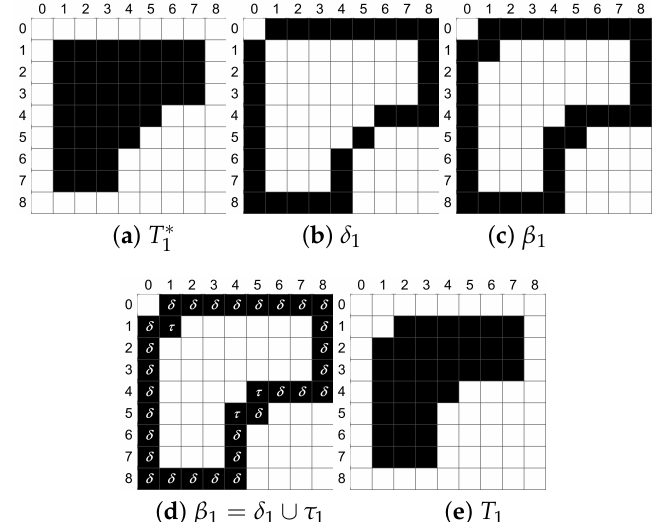
Figure 11. Illustrations of transforming T ∗